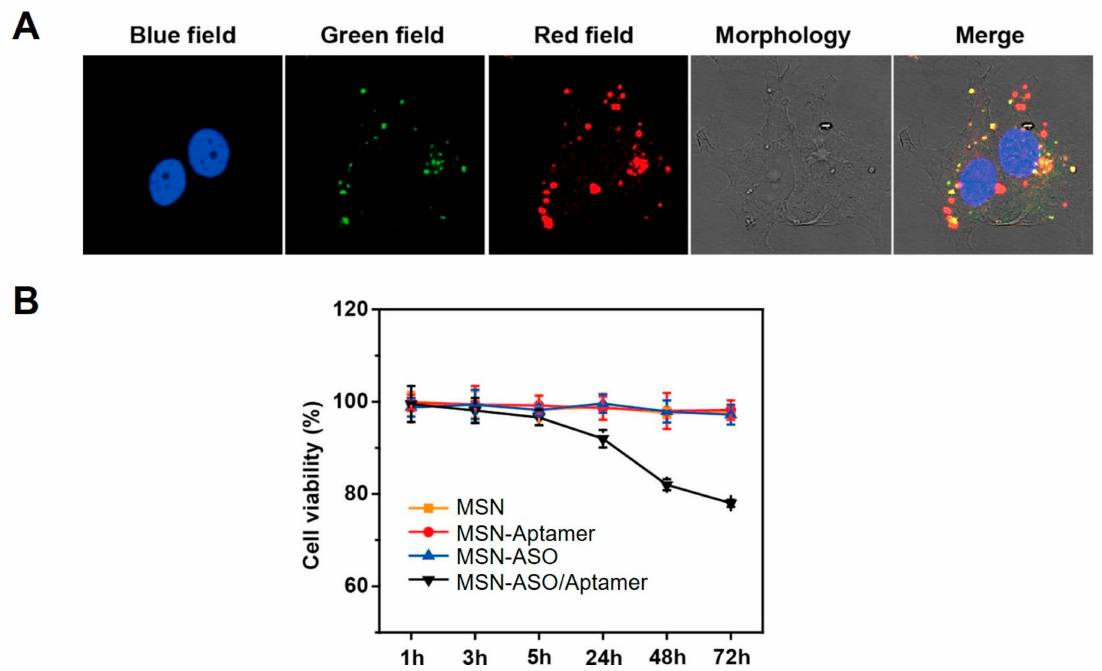
Figure 10. ( A ) Confocal fluorescent images of MCF-7 cells post treatment with MSN-ASO/Aptamer. Blue field, nucleus staining. Green field, FAM-labeled ASO. Red field, MSN fluorescence; ( B ) Cellular viability of MCF-7 cells post treatment with MSN, MSN-aptamer, MSN-ASO, or MSN-ASO/Aptamer. ASO, 50 nM; MSN, 100 µ g/mL. Adapted from reference [71] with